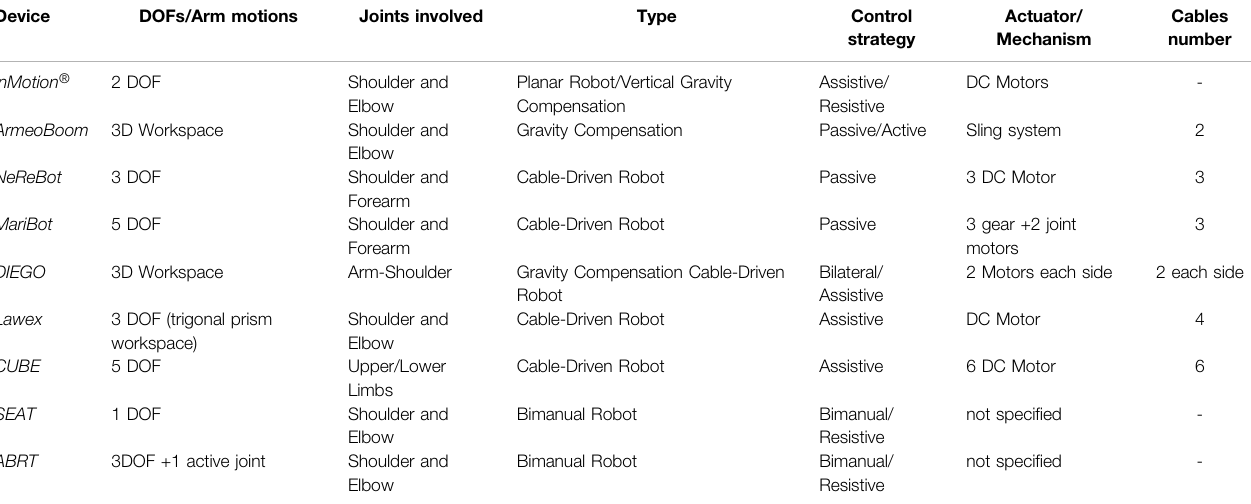
TABLE 1 | Summary of the main characteristics of the devices presented in the